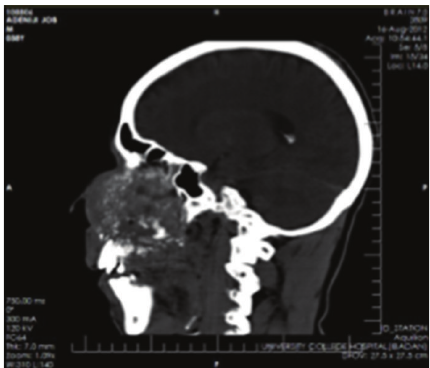
Figure 3: Sagittal computerized tomography (CT)showing destruc- tion of the maxilla and nasal tissues with “floating” upper teeth.